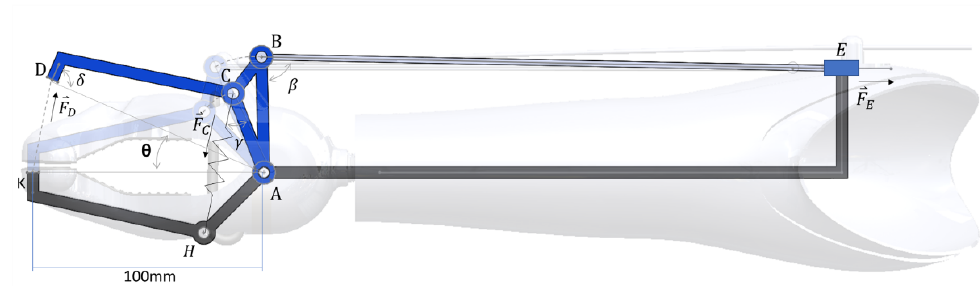
Figure 4. Kinematic diagram.